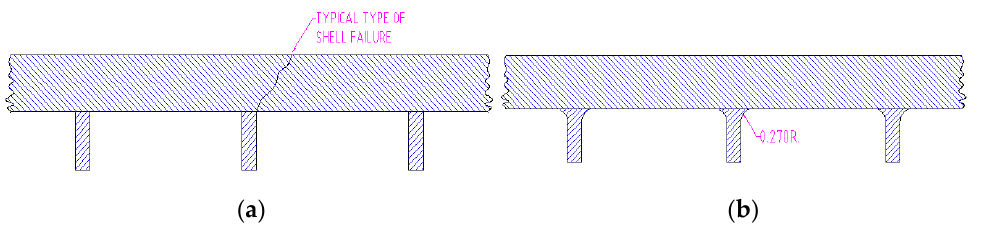
Figure 4. Comparison of design and performance of two different stiffened composite cylindrical shells [24]. ( a ) Cylindrical model without fillets; ( b ) Cylindrical model with fillets.